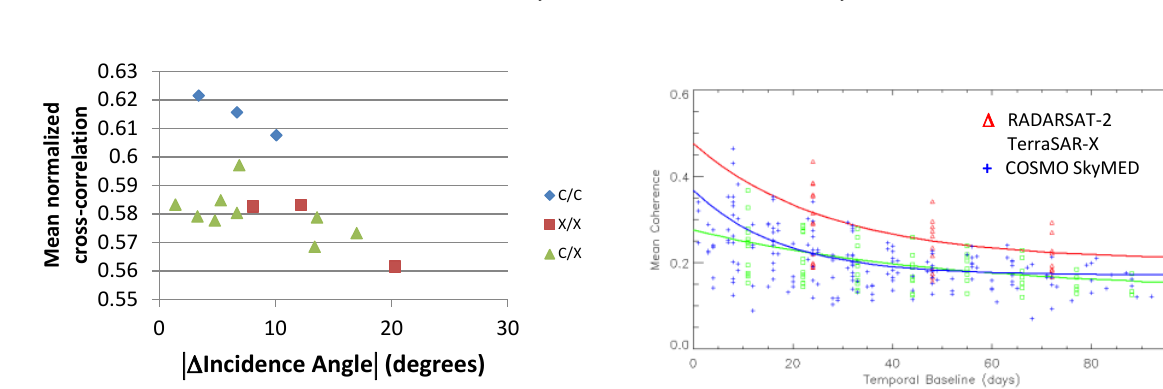
Table 1. Summary of SAR data stacks used in study.